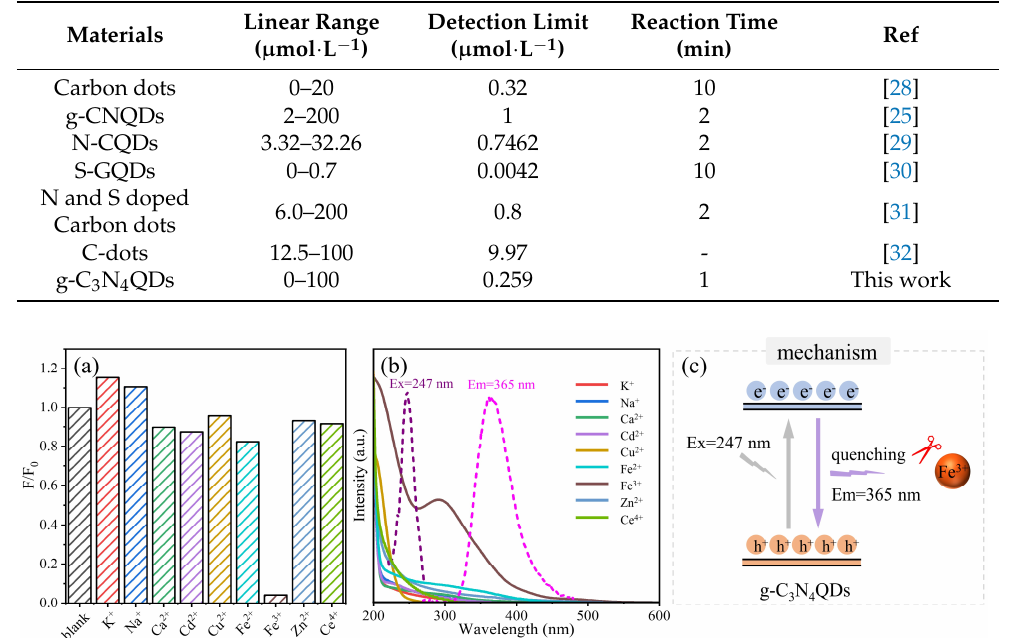
Table 2. Based fluorescent probes for Fe 3+ detection.